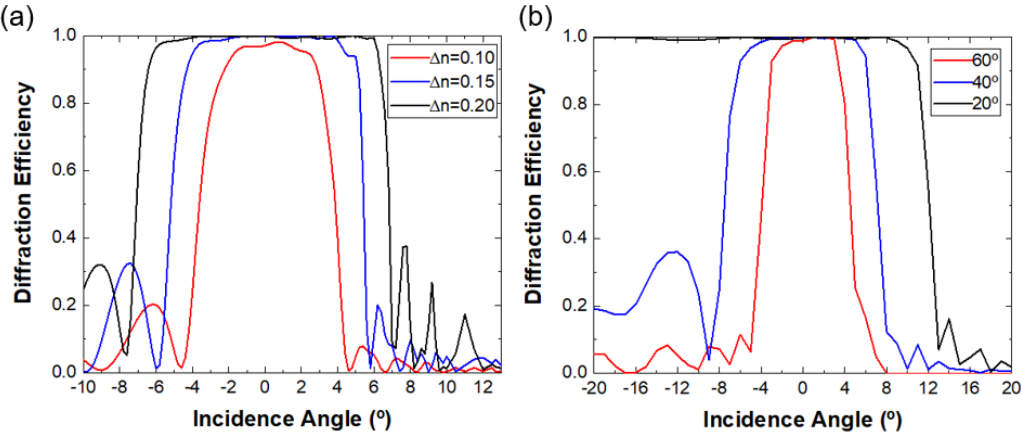
Figure 4. Angular response of PVGs. The horizontal period ( P x ) is 440 nm, vertical period ( P z ) is 205 nm, and the central wavelength is 532 nm. ( a ) Diffraction efficiency versus incident angle at three refractive index contrasts with 50° diffraction angle and ( b ) three diffraction angles with Δ n = 0.15.